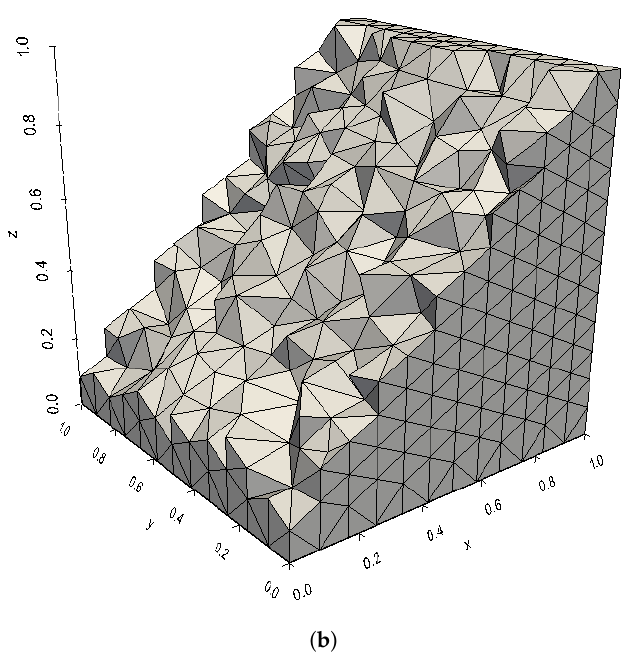
Figure 6. Three-dimensional meshes for the verification process. ( a ) 8000 hexahedra; ( b ) 7982